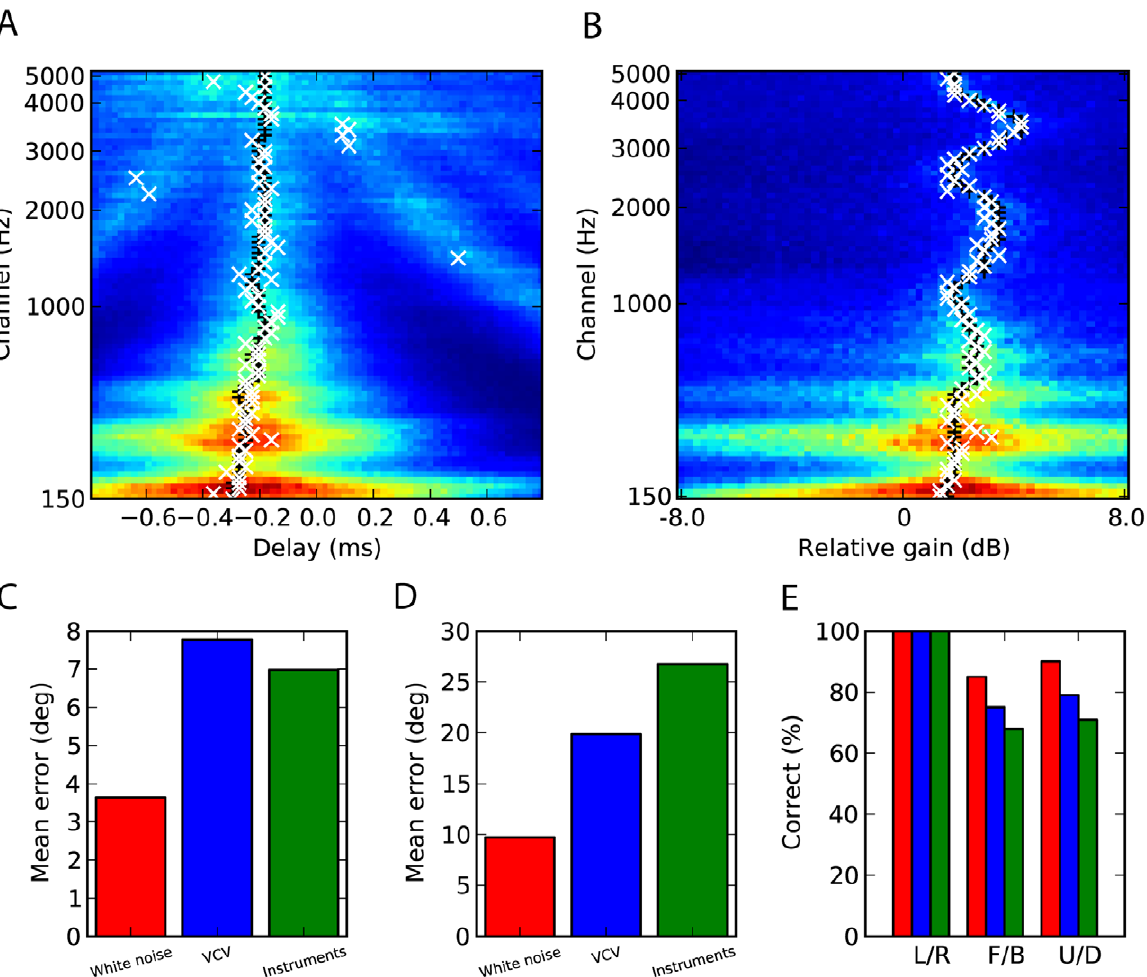
Figure 10. Learning delays and gains. (A, B) Response of a population of postsynaptic neurons with various preferred frequencies, interaural delays and gains to a long broadband sound (10 s) played at a particular location. (A) Maximum neural response (color-coded) over all the gains, for each frequency and relative delay. (B) Maximum neural response over all the delays, for each frequency and relative gain. In both (A) and (B), the white x symbols show the maximum response for each frequency, and the black + symbol shows the choice of best delay (A) and relative gain (B) for that location in the approximate model, based on the cross-correlation of HRIRs. (C, D, E) Performance of the approximate model (as in Figure 8) using delays and gains learned from hearing 7 example sounds of 1 s duration from each